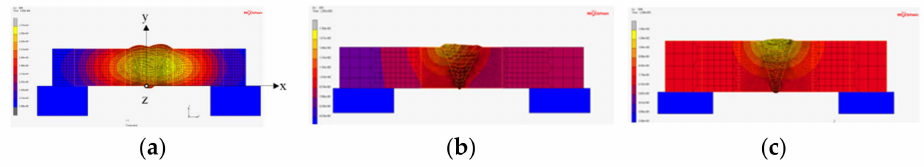
Figure 11. Temperature distributions for different thicknesses: ( a ) 25 mm, ( b ) 50 mm, and ( c ) 70 mm.